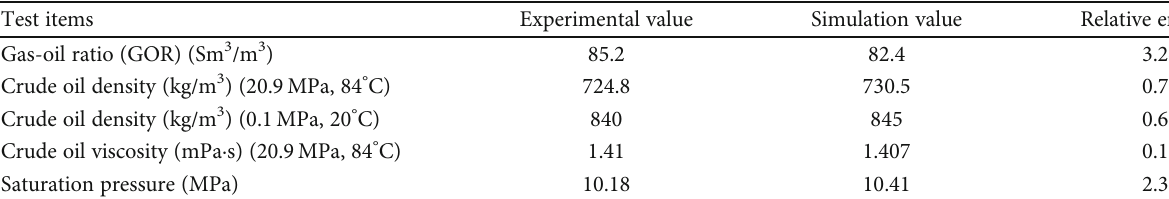
Table 6: Single fl ash test results of crude oil.